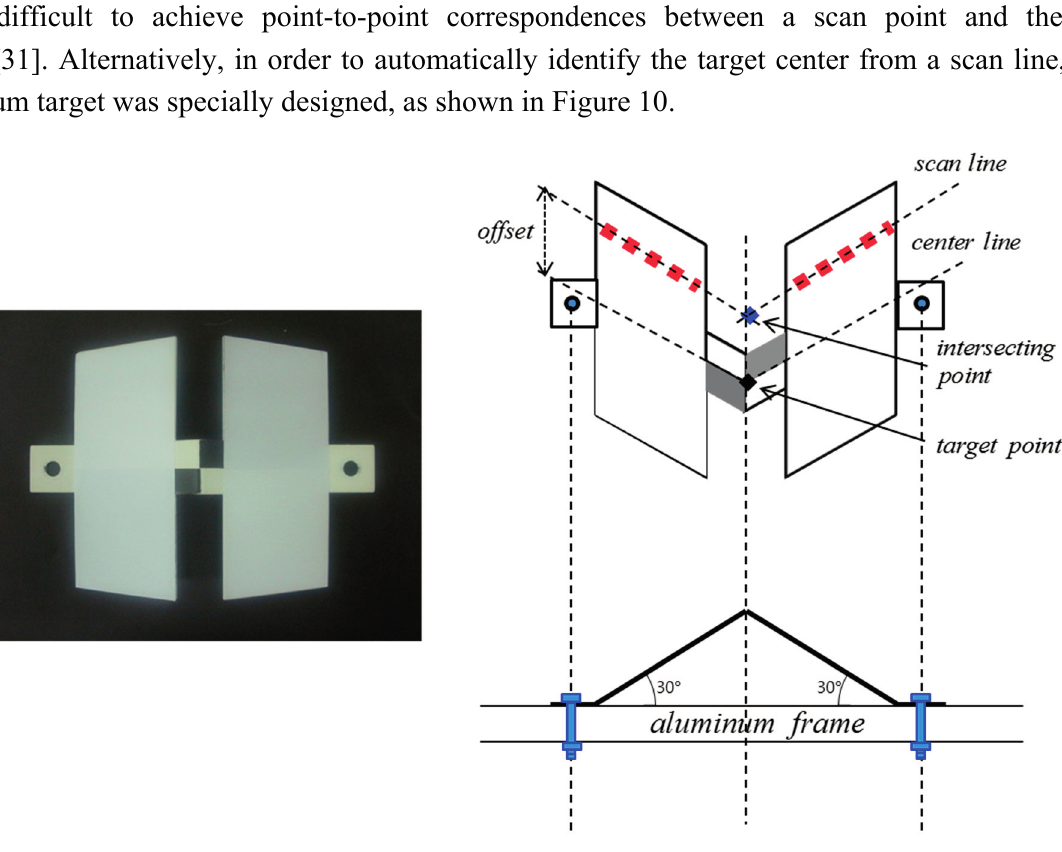
Figure 10. Target design for automated detection of target